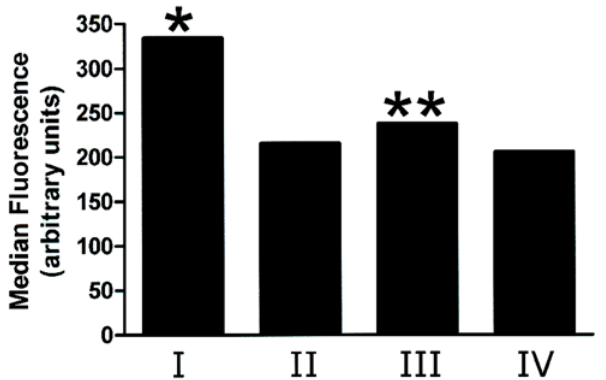
Figure 5. VWF induces conformational changes in ADAMTS13 at 37 u C which are inhibited by prior labeling with the mAb Wh2-11-1. ADAMTS13 from HEK293 cells was incubated with the mAb Wh2-11-1 and VWF under the following conditions: (I) ADAMTS13 was treated with VWF at 37 u C prior to addition of Wh2-11-1. (II) ADAMTS13 was treated with Wh2-11-1 at 37 u C followed by the addition of VWF. (III) ADAMTS13 was treated with VWF at 4 u C prior to addition of Wh2-11-1. (IV) ADAMTS13 was treated with Wh2-11-1 at 4 u C followed by the addition of VWF. *Reactivity of ADAMTS13 to Wh2-11-1 is significantly higher (p , .001) in the presence of VWF at 37 u C. **There is no significant difference between the reactivity of Wh2-11-1 to ADAMTS13 in the presence or absence of VWF at 4 u C (p=0.083). Binding of mAb was monitored by flow cytometry. The figure represents data from one of five independent experiments.